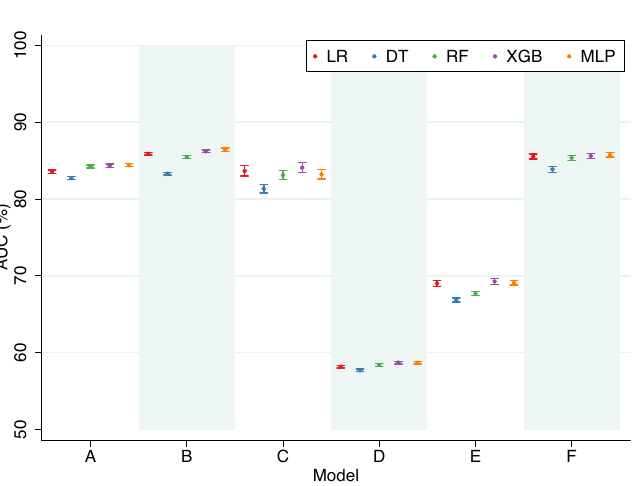
Table 2. Performance of models for predicting preterm birth at 10% FPR using tenfold cross-validation, by classification algorithms. AUC, area under the receiving-operator characteristic curve; TPR, true positive rate (recall or sensitivity); PPV, positive predictive value (precision); NPV, negative predictive value; LR + , positive likelihood ratio; LR − , negative likelihood ratio; CI, confidence interval; FPR, false positive rate (1-specificity); LR, regularised logistic regression; DT, decision trees; RF, Random Forests; XGB, extreme gradient boosting; MLP, multi-layer perceptron. Model A: Cohort—all births; Predictors—maternal socio-demographic factors, maternal chronic medical conditions, and current pregnancy characteristics and complications; Model B: Cohort—births of multiparous women; Predictors—Model A + maternal past obstetric history; Model C: Cohort—births of parents who were born during the study period; Predictors—Model A + parent’s birth outcomes and grandmother’s chronic medical conditions and obstetric history; Model D: Cohort—all births;